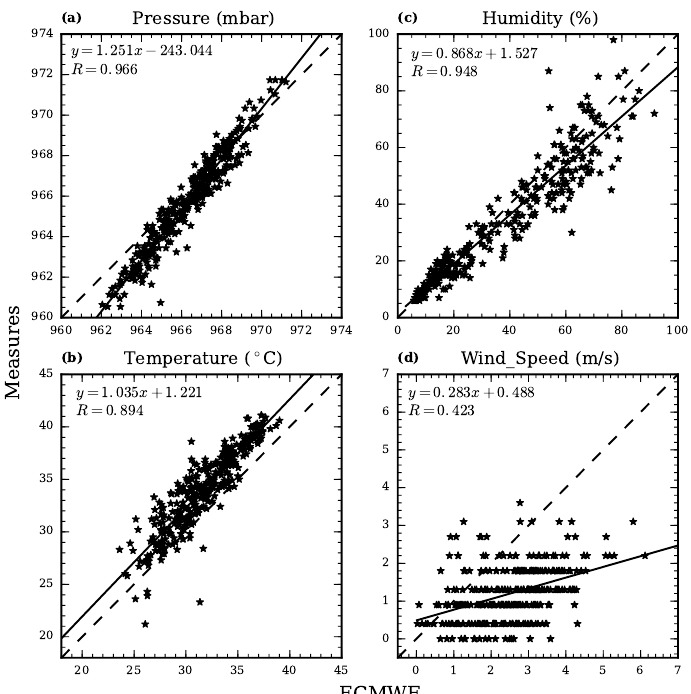
Figure 2. Comparison between meteorological parameters measured and those extracted from European Center for Medium-Range Weather Forecasts (ECMWF) data in Maroua in 2014 for ( a ) pressure, ( b ) temperature, ( c ) humidity and ( d ) wind speed at ground level. Solid lines represent linear regression curves and dashed lines are slope